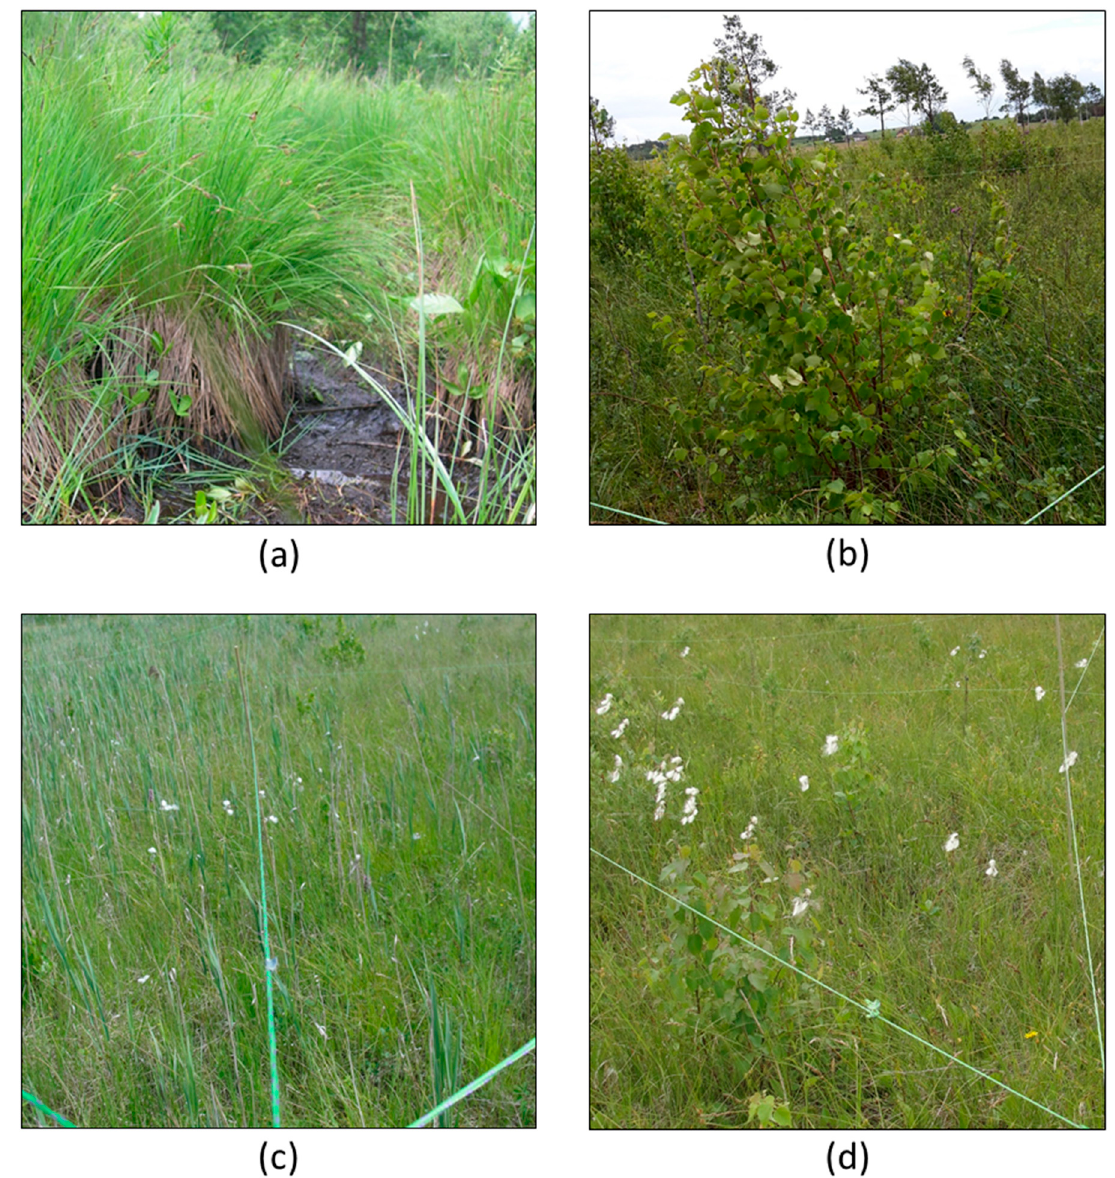
Figure 3. Pictures of vegetation present in the research area: big sedge communities ( a ), wet meadow encroached by birch trees ( b ), fen meadow—molinion ( c ), and pristine fen ( d